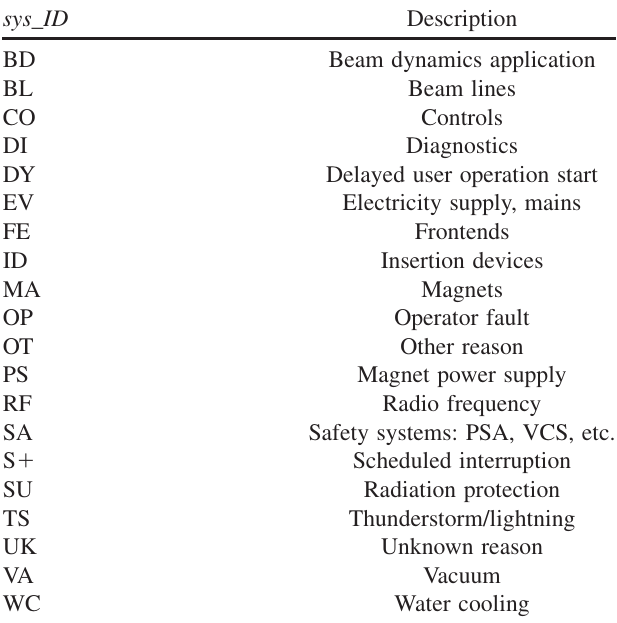
TABLE III. SLS failure groups.